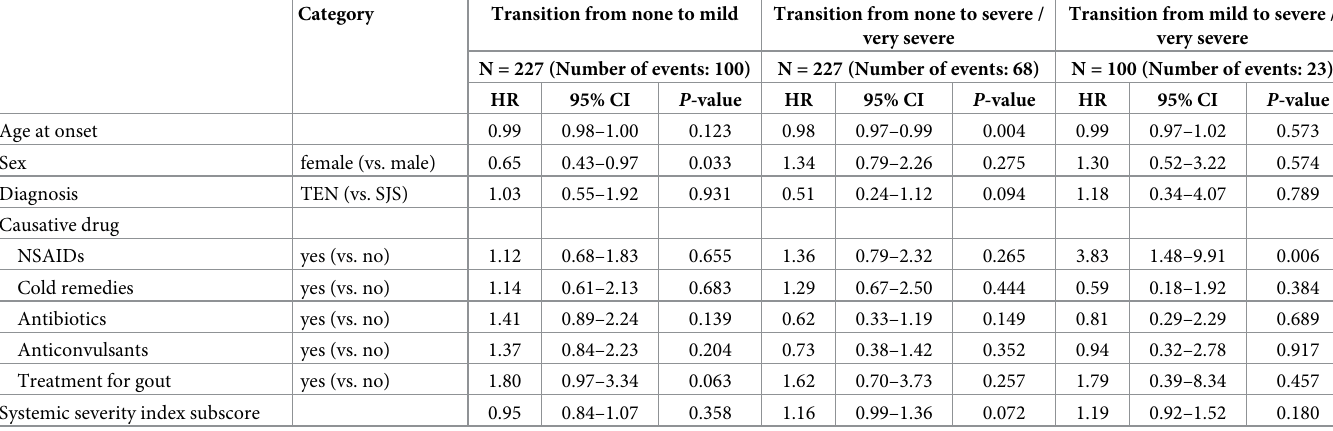
Table 6. HRs and 95% CIs for prognostic factors of each transition by multi-state model analysis.